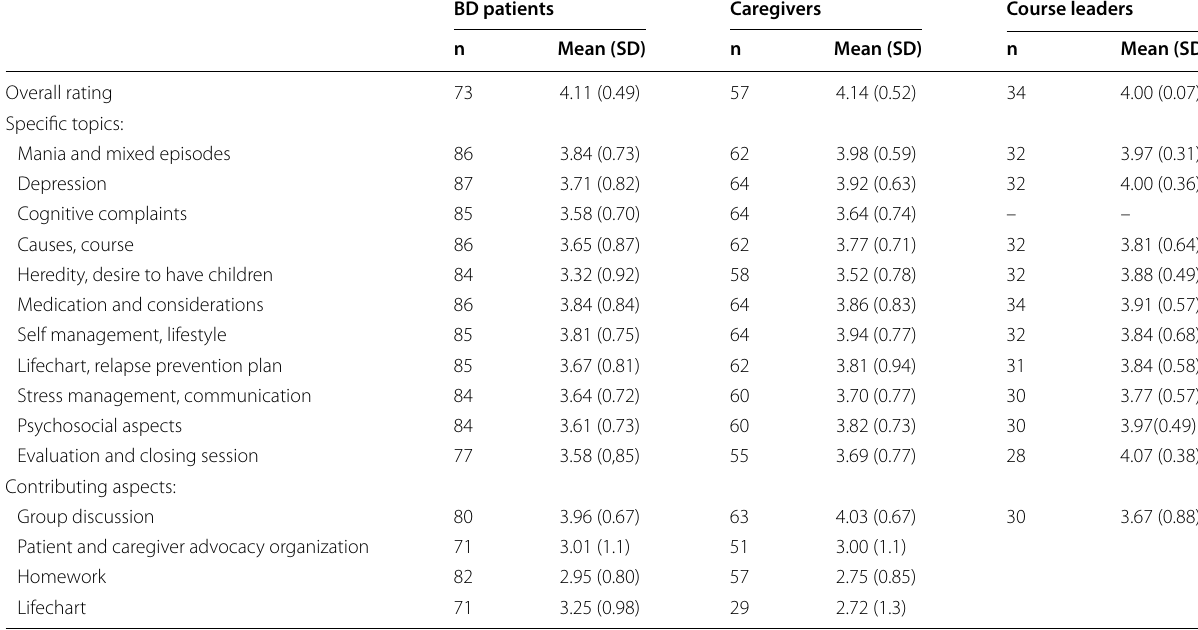
Table 3 Program evaluation by patients, caregivers and course leaders(mean scores bases on differential scale ranging from 1 to 5. with 1 (‘very bad’) and 5 (‘very